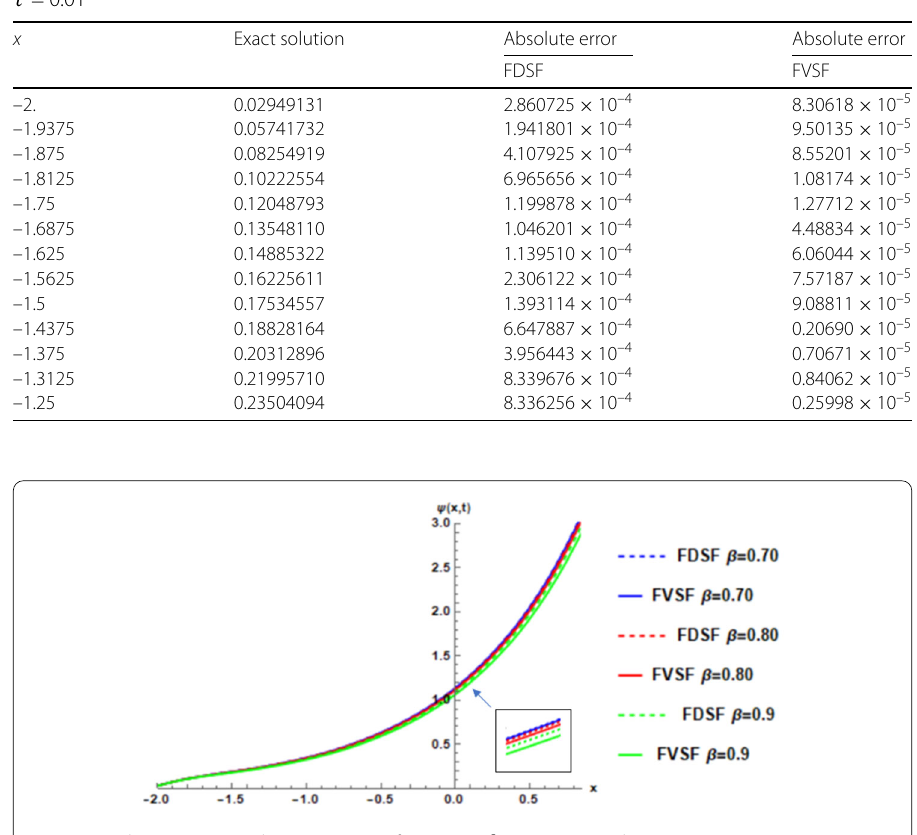
Figure 4 Solutions to Example 2 at time t = 1 for varying β using FDSF and